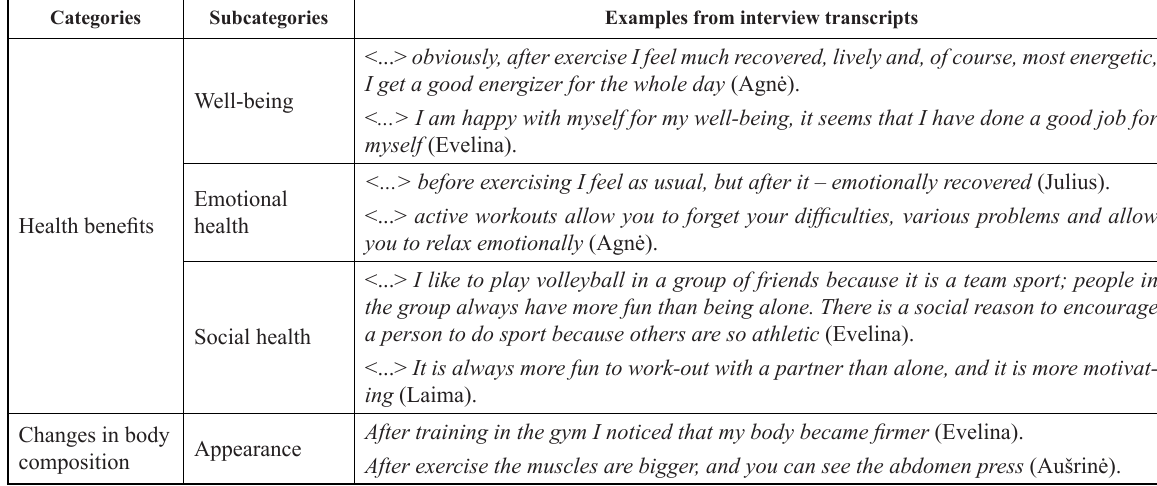
Table 4. Assessment of physical activity of sedentary adults Categories